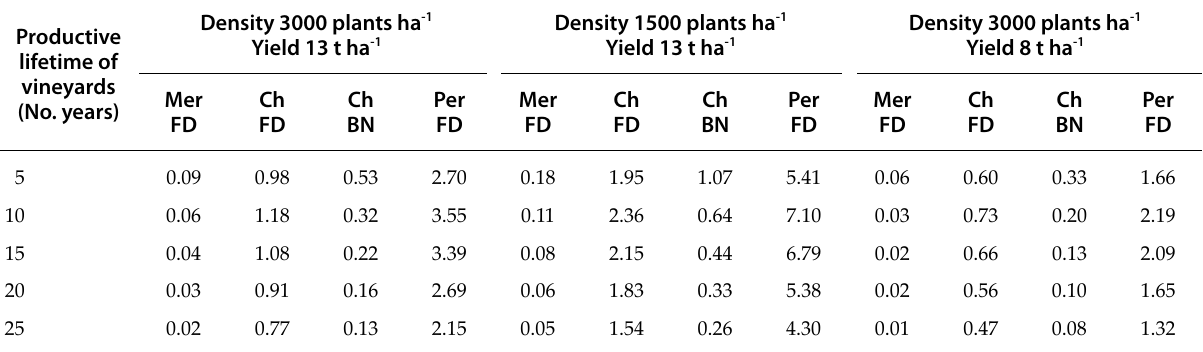
Table 4. Average annual costs of maintenance “MC N ” (€/year/plant) estimated for three grapevine cultivars in relation to different productive lifetimes of vineyards, density of plants per hectare and yield per hectare. Mer = ‘Merlot’; Ch = ‘Chardonnay’; Per =